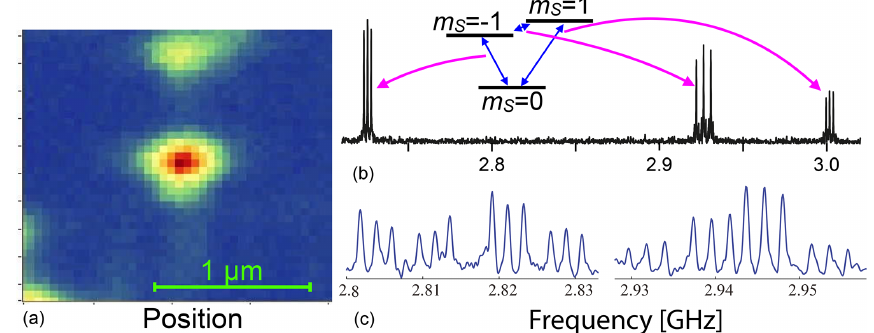
Figure 18. (a) Scanning confocal image of a single NV centre. (b, c) Optically detected ESR spectra of two different NV centres showing hyperfine interaction with the 14 N (b) and the 14 N plus a 13 C (c) nuclear spin.